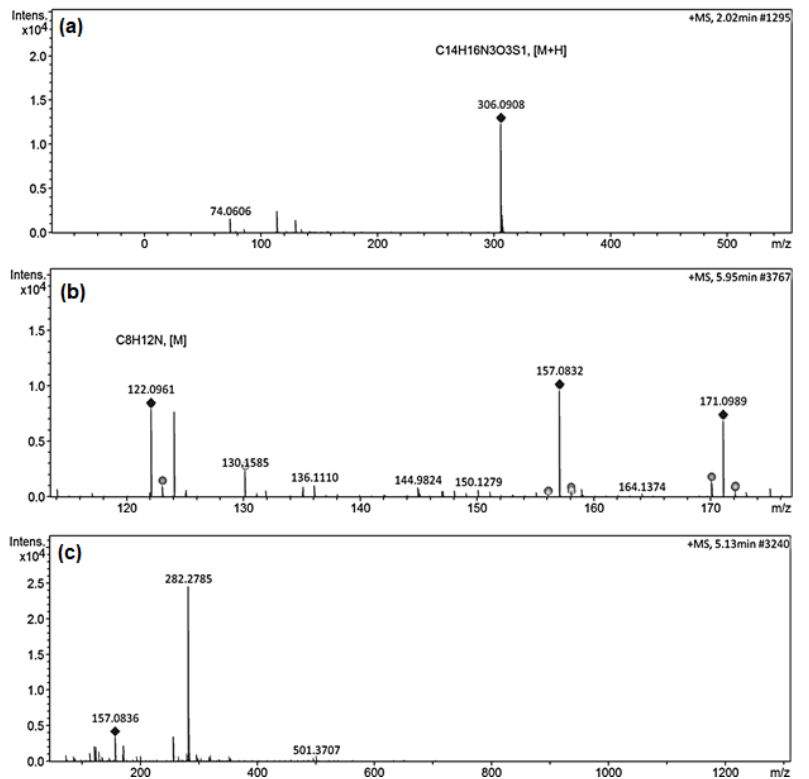
Figure 11. LC-MS analysis of MO dye degradation using Fe/Cu/Ag 5:1:0.2 at ( a ) 0 min ( b ) 5 min and ( c ) 30 min.